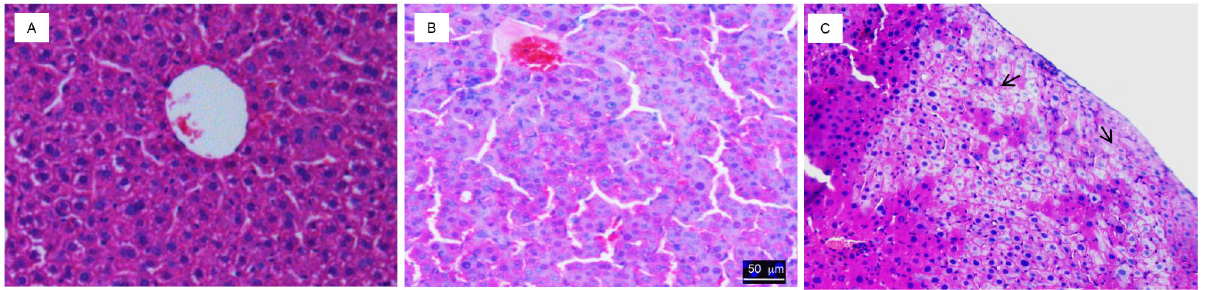
Figure 1. H & E staining of a non-engrafted MUP-uPA-SCID/Bg mouse liver. A . Liver section from a 2-m old transgenic mouse with no necrosis or inflammation. B . Liver section from a 4-m old transgenic mouse. C . Liver section from a 6-m old transgenic mouse shows extensive areas of necrosis